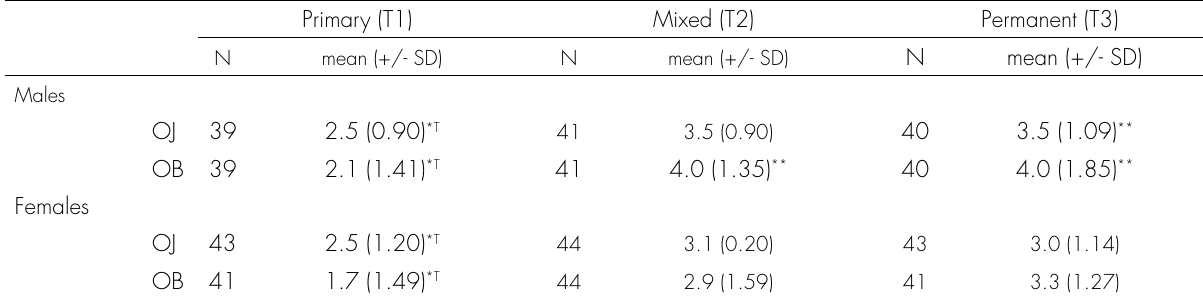
Table I. Mean values and standard deviations for overjet (OJ) and overbite (OB) in males and females (in mm) from pooled MZ and DZSS twin data in the primary (T1), mixed (T2), and permanent (T3) dentitions.